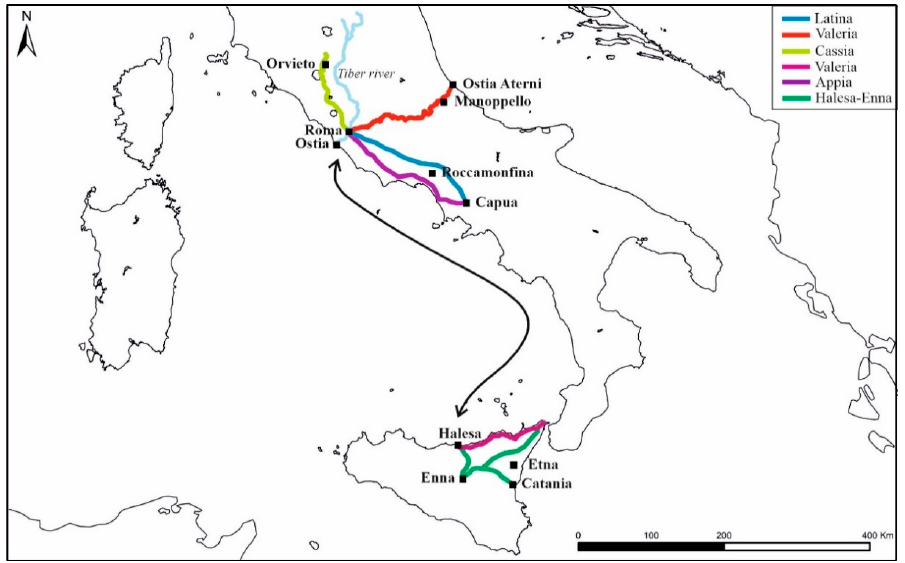
Figure 7. Roman trade routes for exporting lithic materials.